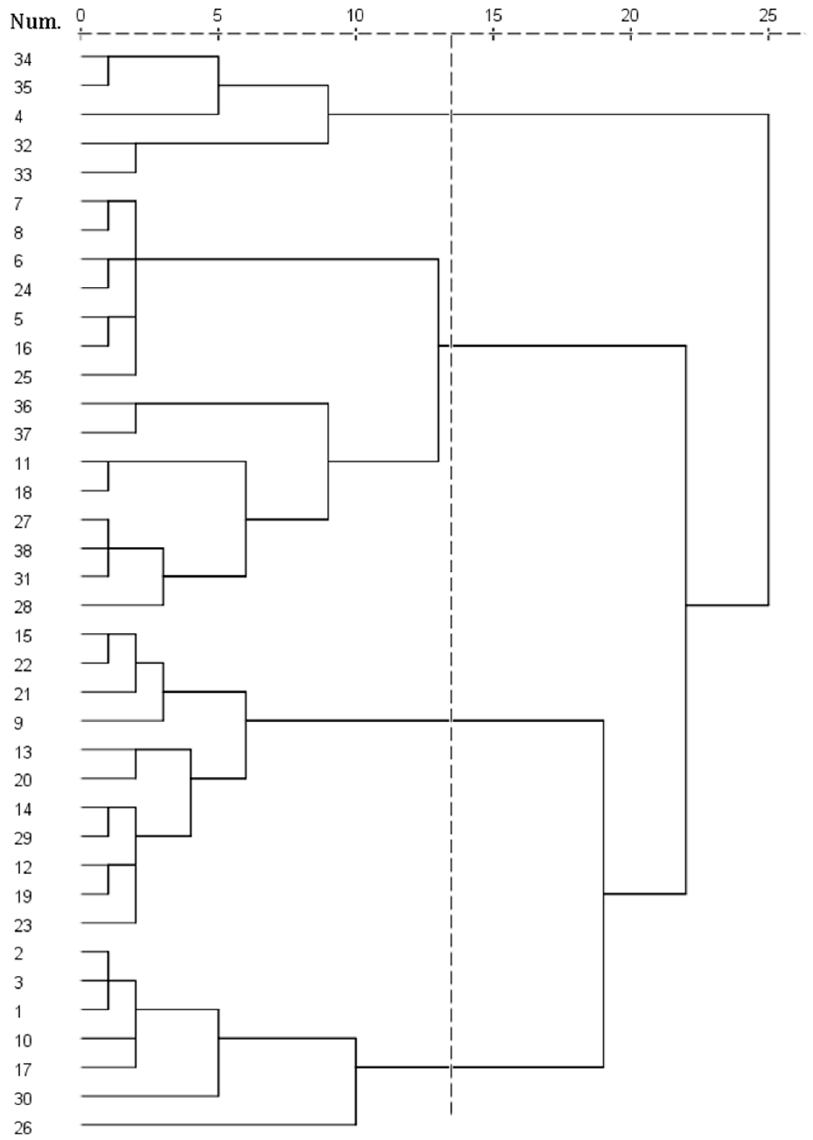
Figure 3. Dendrogram showing the clustering of the sampling sites according to Ward’s Method using the squared Euclidean distance.